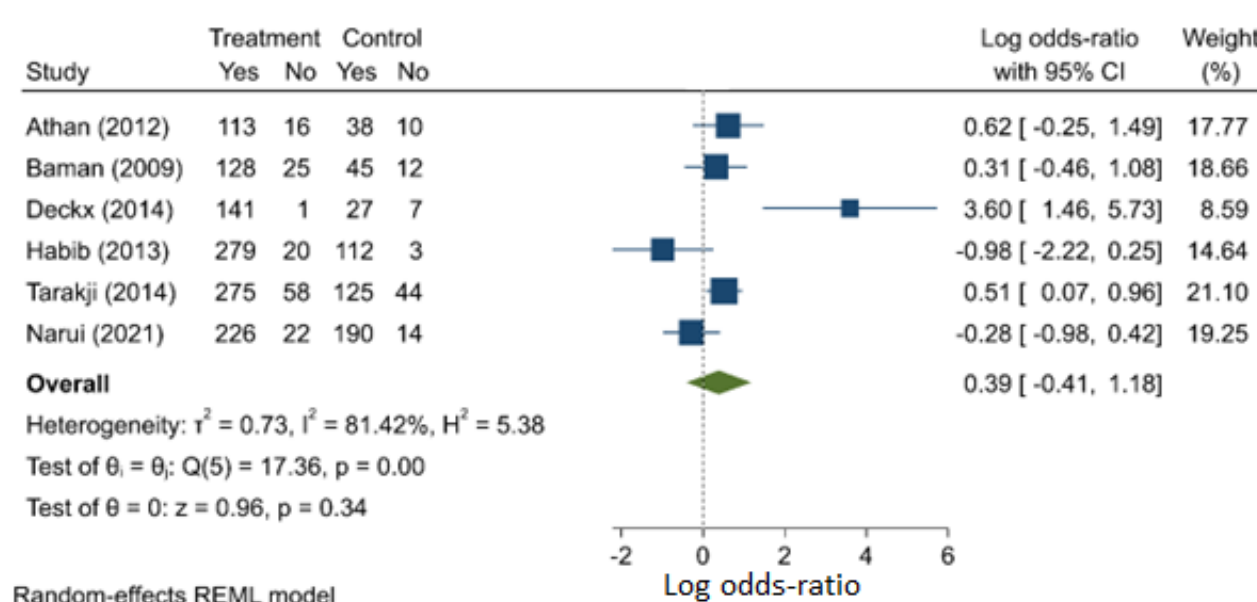
Figure 6. Presence of diabetes mellitus as risk factor for mortality.